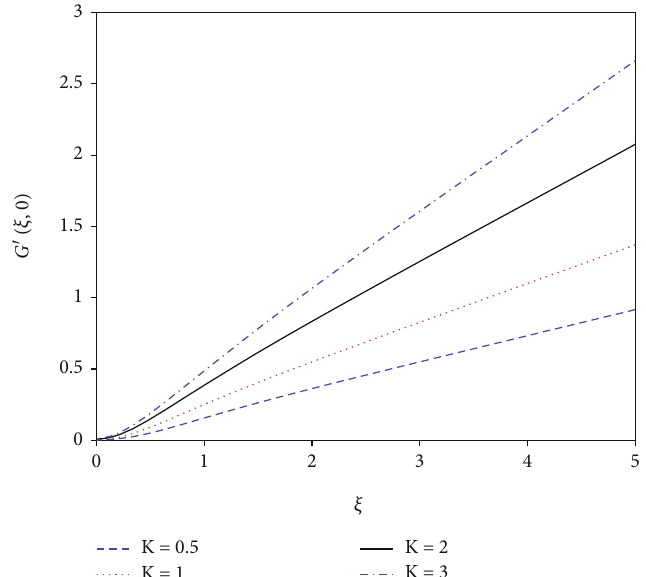
Figure 17: Development of the rate of the gyration component at the wall G ′ ð ξ , 0 Þ for di ff erent values of vortex viscosity parameter K , when n = 1, ξ = 5, Pr = 10, and S = N = He = Ω = 0 : R